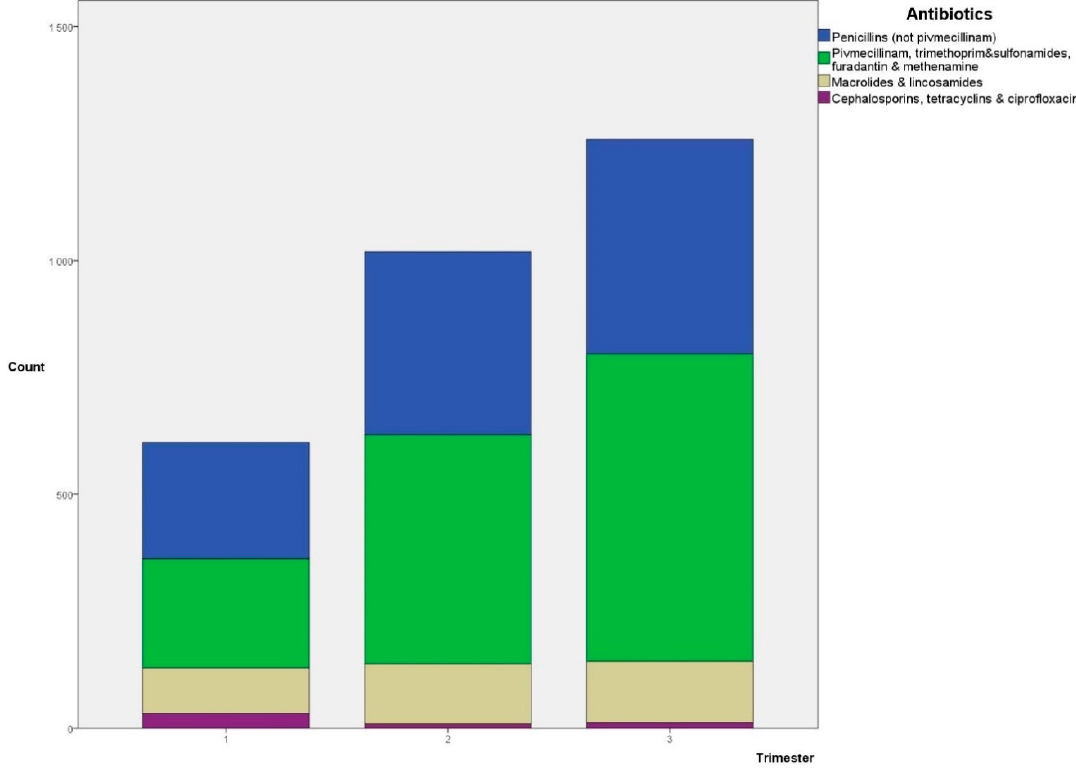
Figure 1. Chart showing the distribution of different antibiotics dispensed to pregnant women according to trimesters.